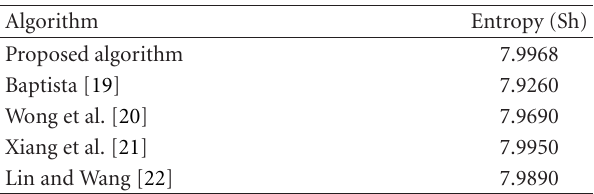
Table 5: Comparison of entropy values of encrypted images under di ff erent image encryption